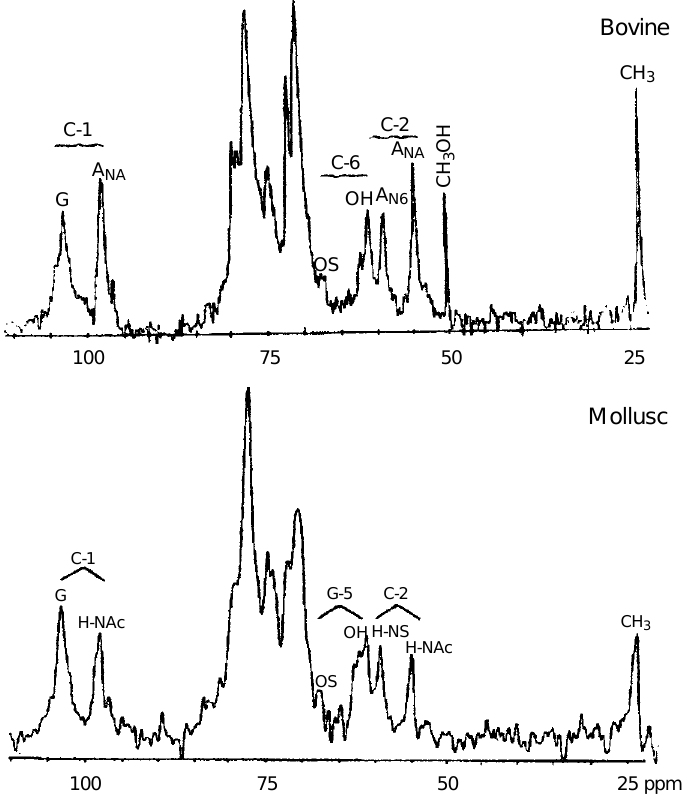
Figure 5 - [ 13 C]-NMR of mammalian and mollusc heparan sulfates. G, Glucuronic